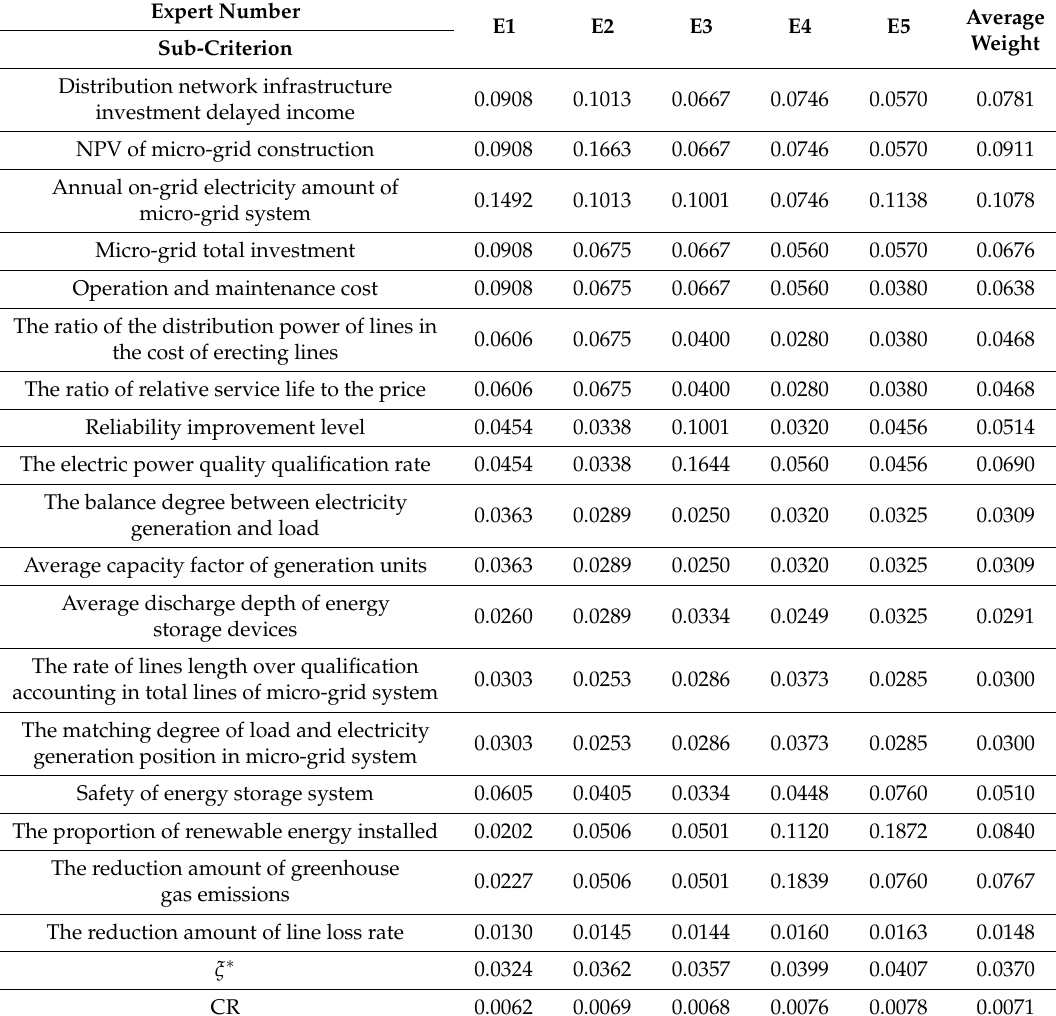
Table 10. Optimal subjective weights and